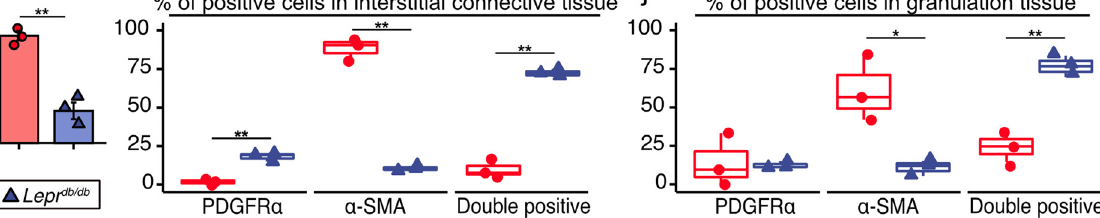
tissue (Fig. 2a). We evaluated the histological wound healing score at 8 DPW using H&E staining and Masson trichrome staining 36 .